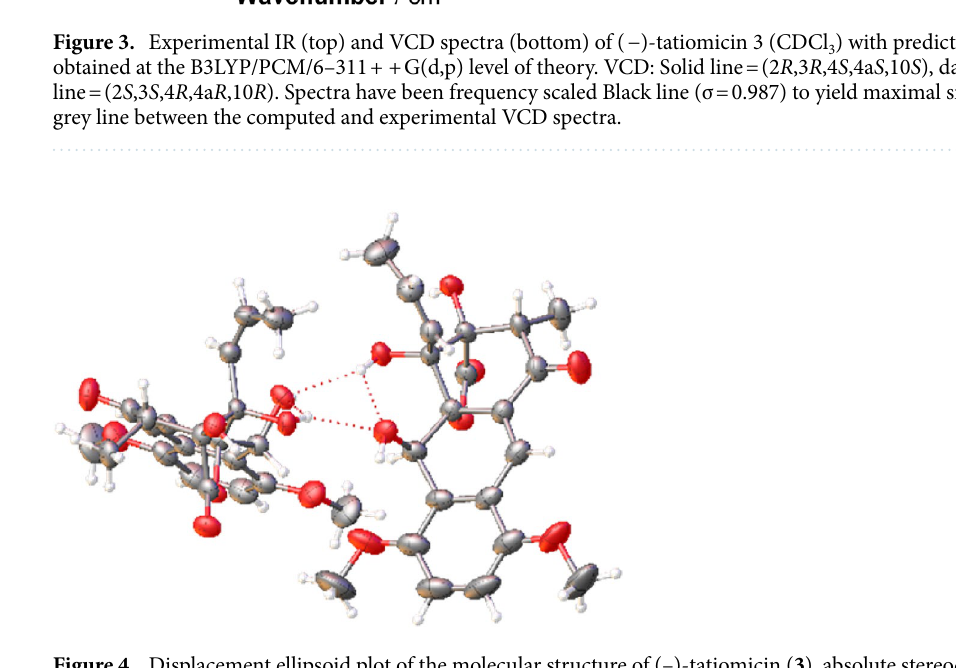
Figure 4. Displacement ellipsoid plot of the molecular structure of (–)-tatiomicin ( 3 ), absolute stereochemistry as shown determined by resonant scattering the dimer molecular structure (Flack parameter = 0.05(6)). Displacement ellipsoids shown at 50% probability